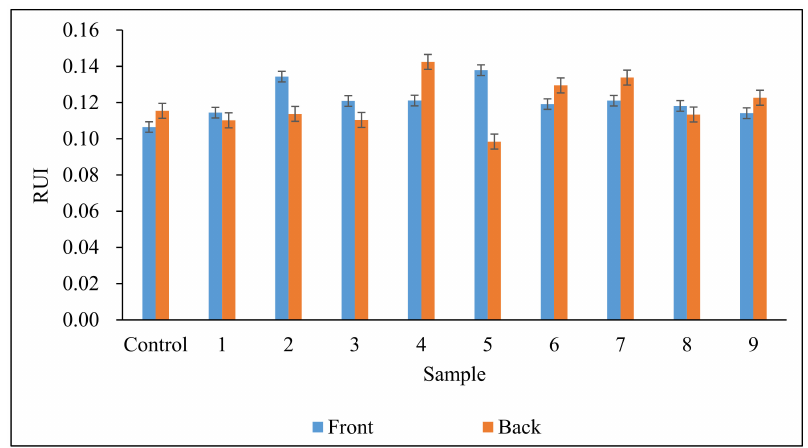
Figure 3. RUI of 5 g/L pigment-dyed cotton samples (Front: atmospheric pressure plasma-treated fabric side; Back: non-atmospheric pressure plasma-treated fabric side).